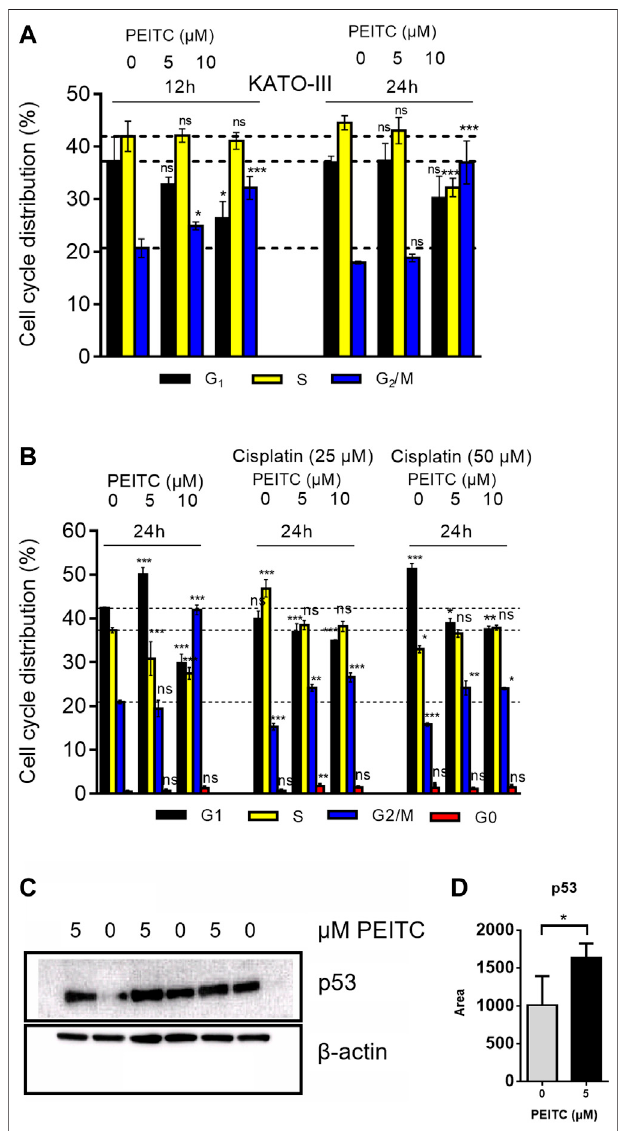
FIGURE 7 | Cell cycle analysis of PEITC (A) and PEITC + cisplatin (B) in KATO-III cells. Analyzed using FACS Canto cell cycle sorter with 20,000 cell reads/sample. Distribution is derived from histograms in FACS Diva software. Mean ± SD of n (cid:1) 3 replicates/treatment. ANOVA with Dunnett ’ s test (2- sided) vs. control groups was used. Western blot assessment of proteins p53 and β -actin (control) in response to PEITC were included in triplicates (C) . p53 band area were quanti fi ed in Image Studio Lite (D) . Bars represent means ± SD. Independent samples t -test (one-tailed) between 0 and 5 µM *: p < 0.05.